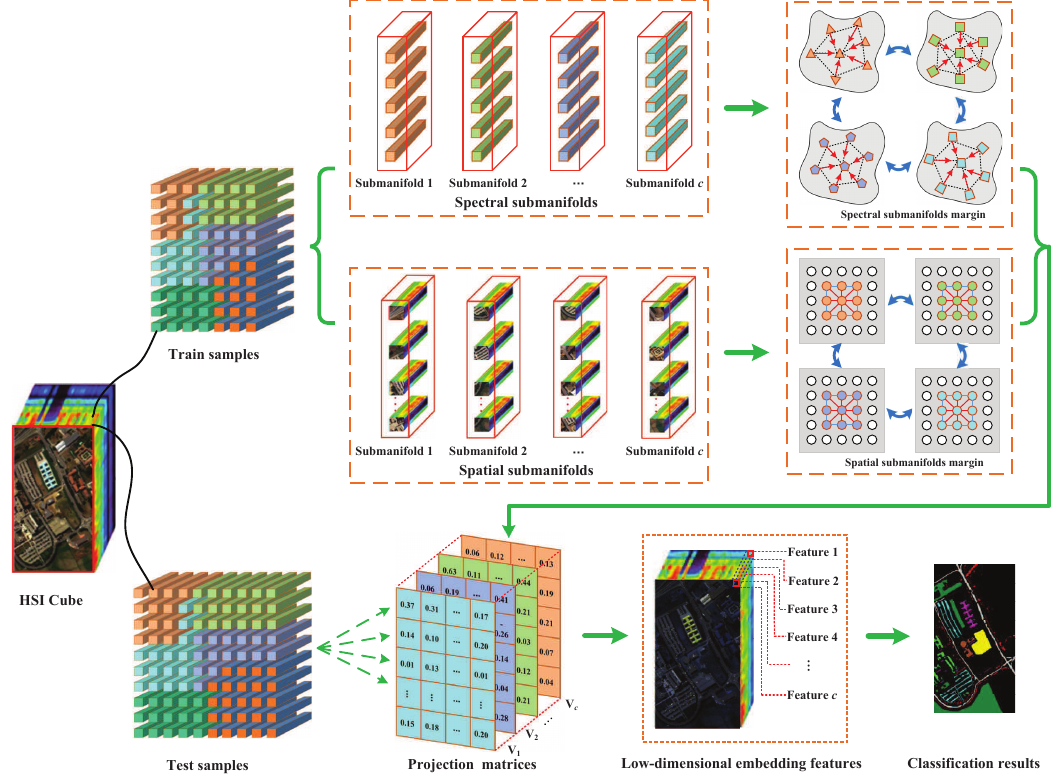
Figure 1. The flowchart of the proposed spatial-spectral multi-manifold discriminant analysis (SSMMDA)